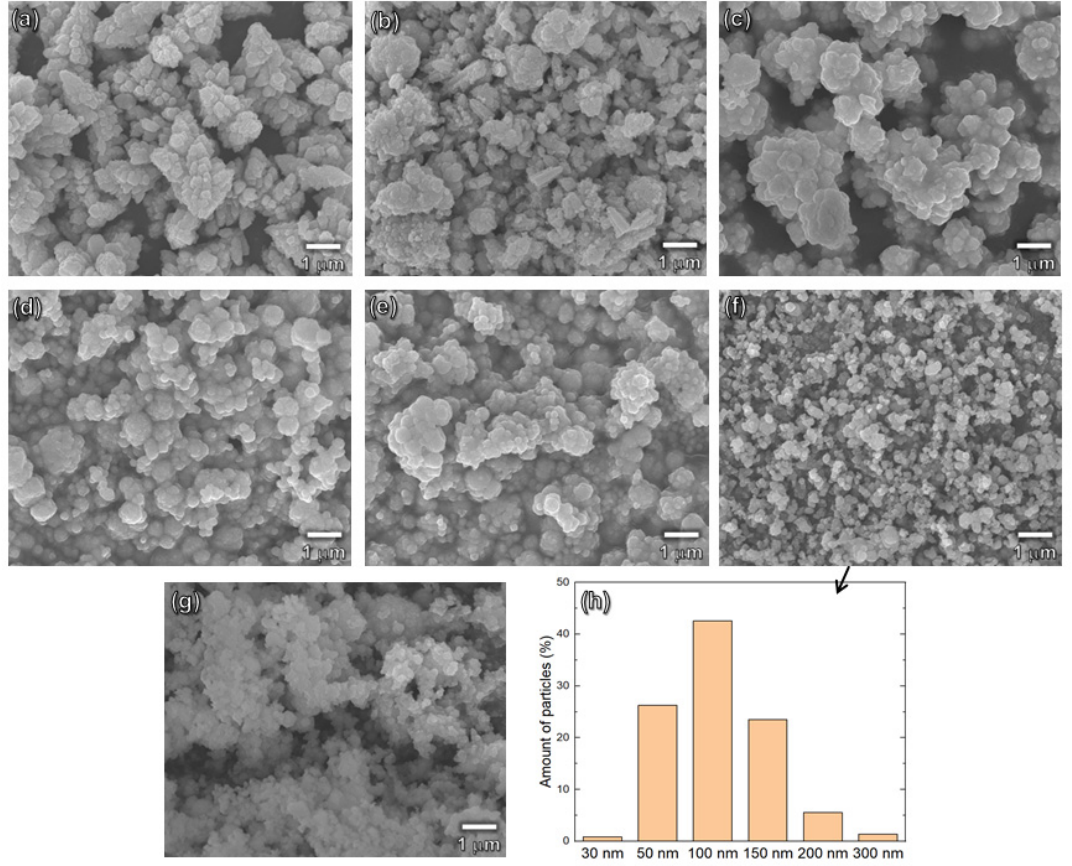
Figure 2. Scanning electron microscopy (SEM) images of various cadmium sulfide (CdS) samples (( a ): EG0-H; ( b ): EG0+H; ( c ): EG25+H; ( d ): EG50+H; ( e ): EG75+H; ( f ):EG100+H; ( g ):EG100-H) and the particle size distribution of EG100+H sample ( h ).